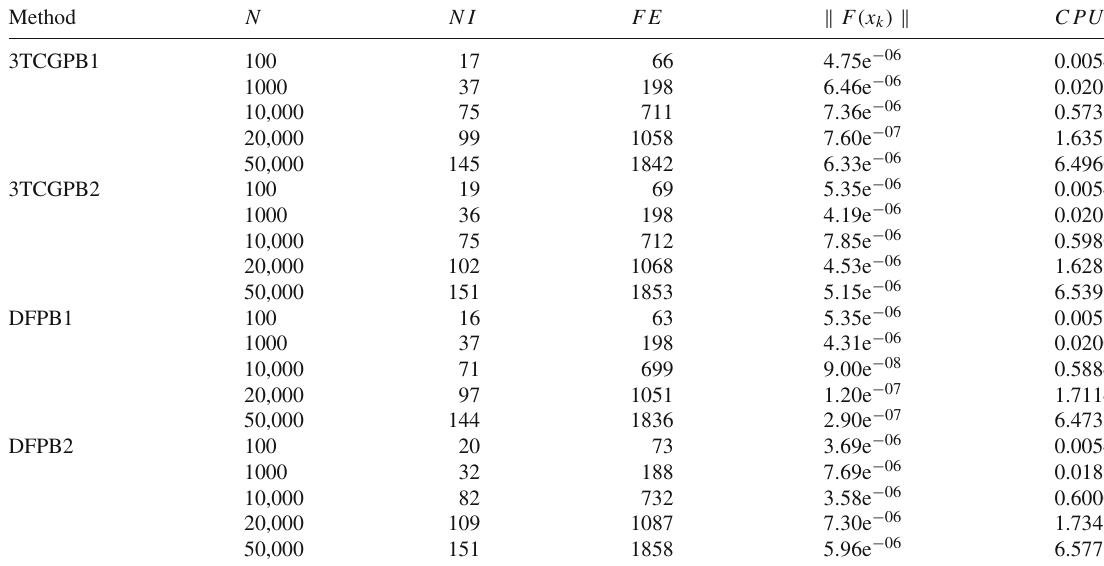
Table 4 Numerical results of Problem